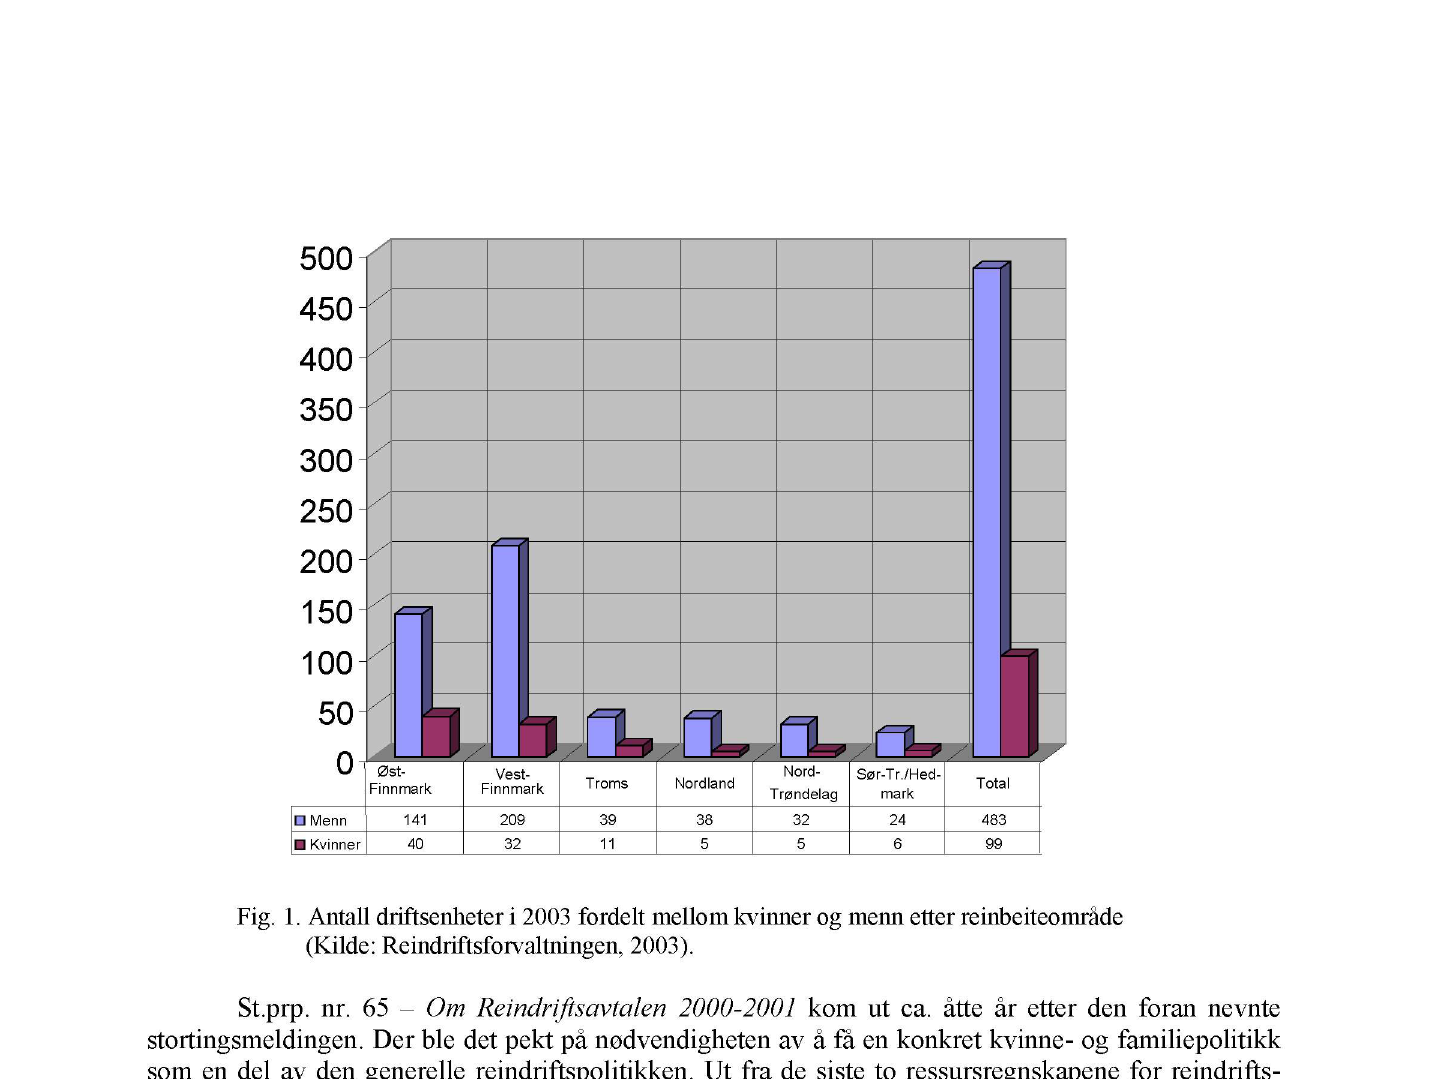
Fig. 1. Antall driftsenheter i 2003 fordelt mellom kvinner og menn etter reinbeiteområde (Kilde: Reindriftsforvaltningen,